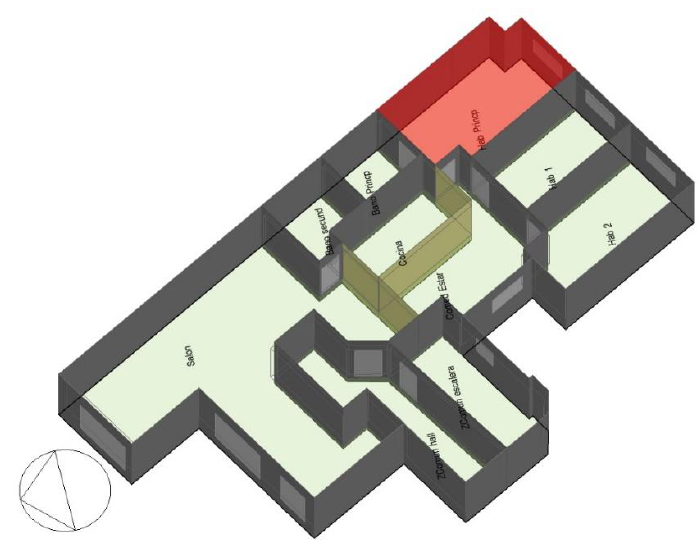
Figure 7. Model of the loft flat in the Design Builder program.